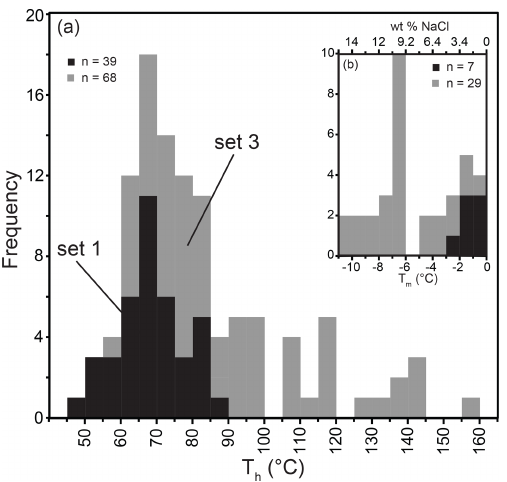
Figure 5. (a) Fluid inclusion (two-phase) homogenization tempera- tures from vein set 1 and 3. (b) Fluid inclusion melting temperatures from vein sets 1 and 3 and the calculated salinity (as wt% NaCl; see text for